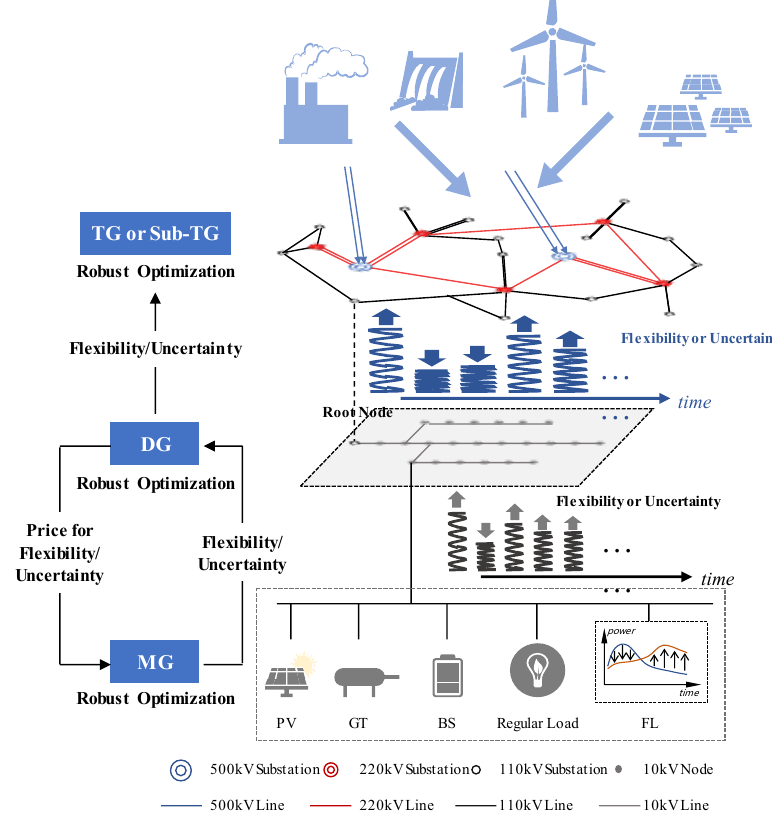
Figure 1. Framework for multi-level scheduling.